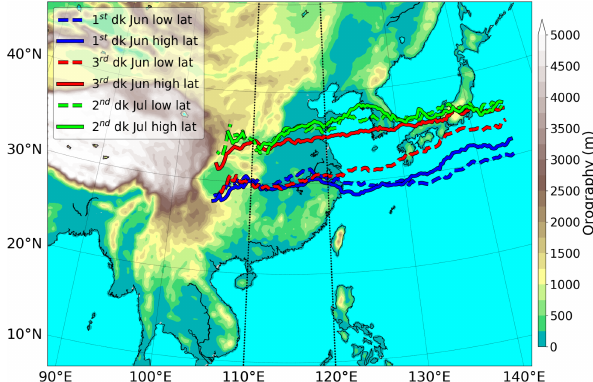
Figure 13. Dekadal mean location of EASM frontal band at 850hPa. As in Fig. 2, but for high-lat and low-lat years and only for selected dekads (see